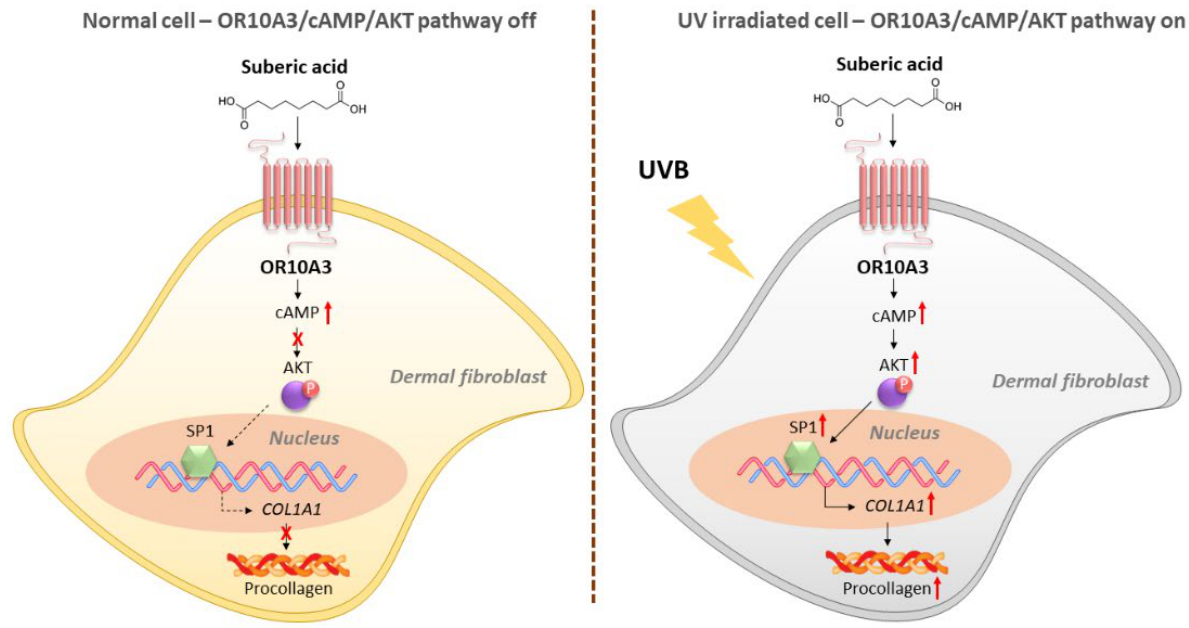
Figure 8. A schematic diagram illustrating the proposed mechanism by which suberic acid increases collagen through OR10A3/cAMP/Akt-dependent signaling pathway in UV-exposed dermal fibroblasts.